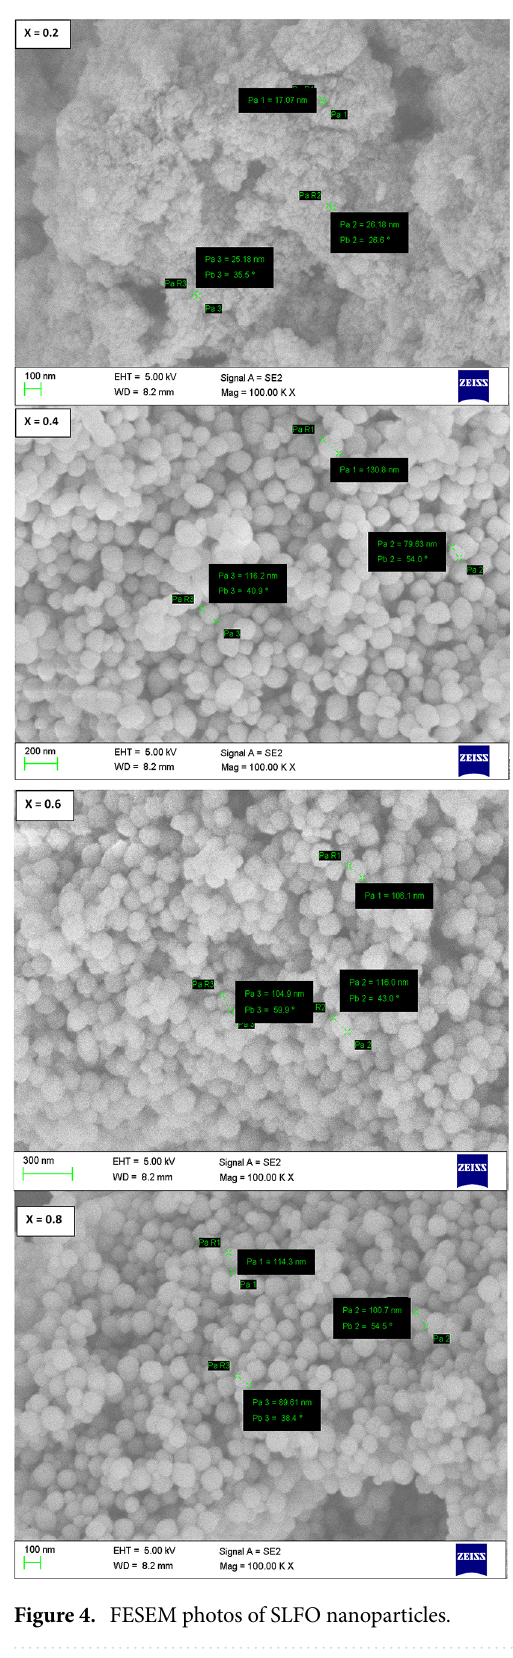
Figure 4. FESEM photos of SLFO